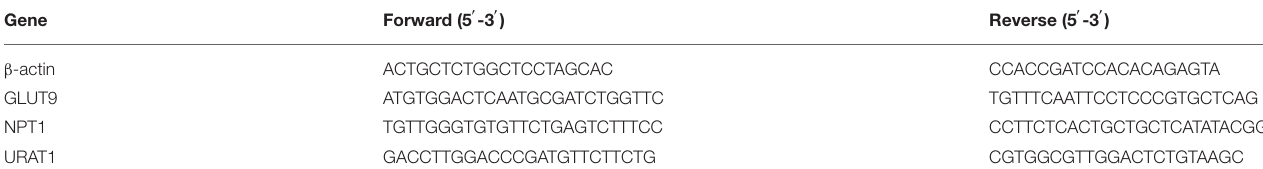
TABLE 1 | Target gene primer sequences. Gene